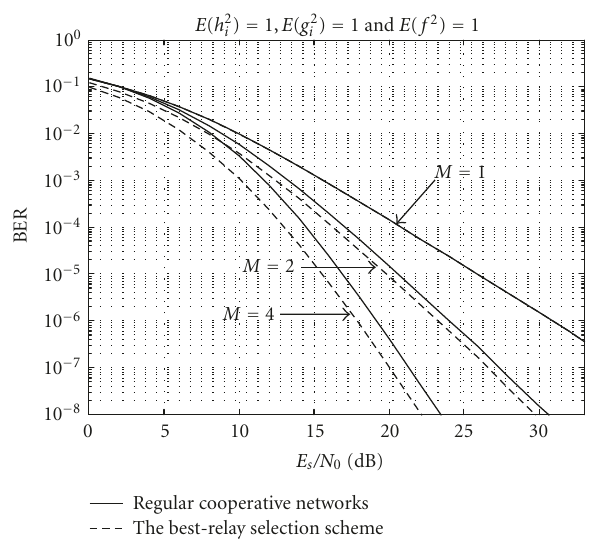
Figure 4: Comparison between the regular cooperative diversity and the best-relay selection scheme over Rayleigh fading channels. (Note that for M = 1, the regular cooperative diversity and best- relay selection scheme are the same.)